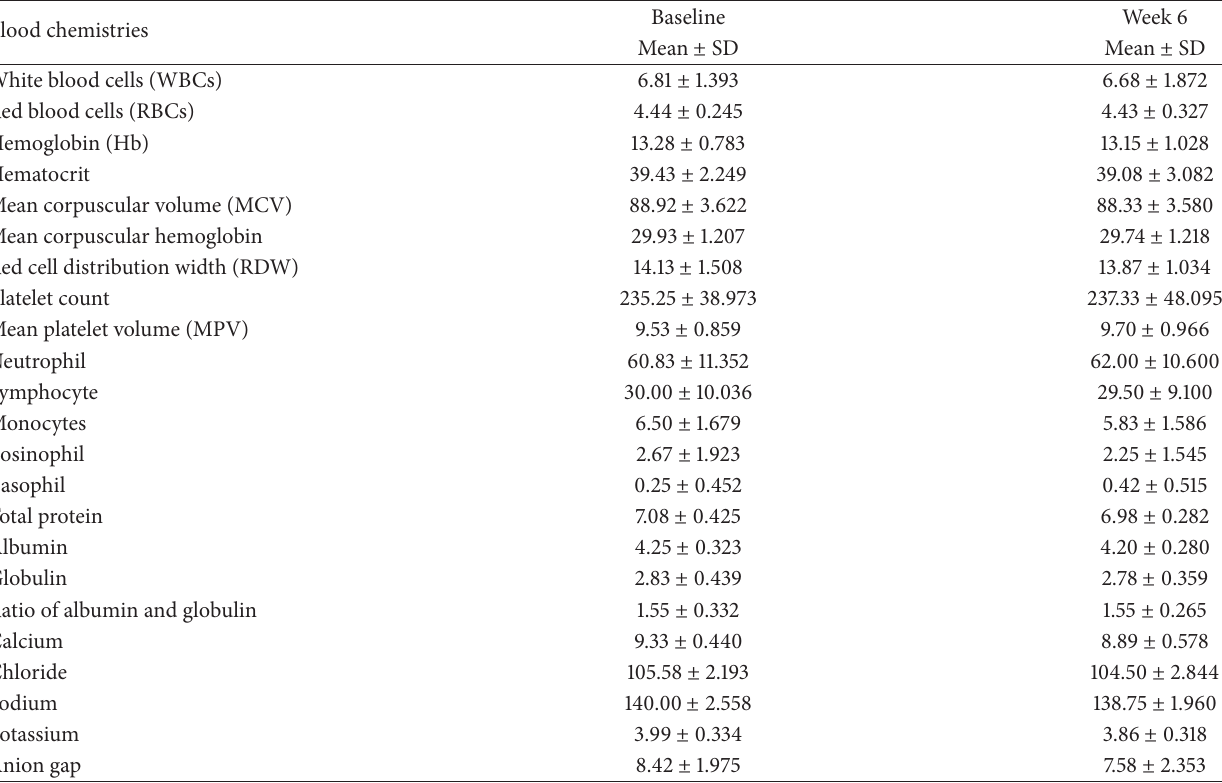
Table 3: Blood chemistries at baseline and week-6 visits.